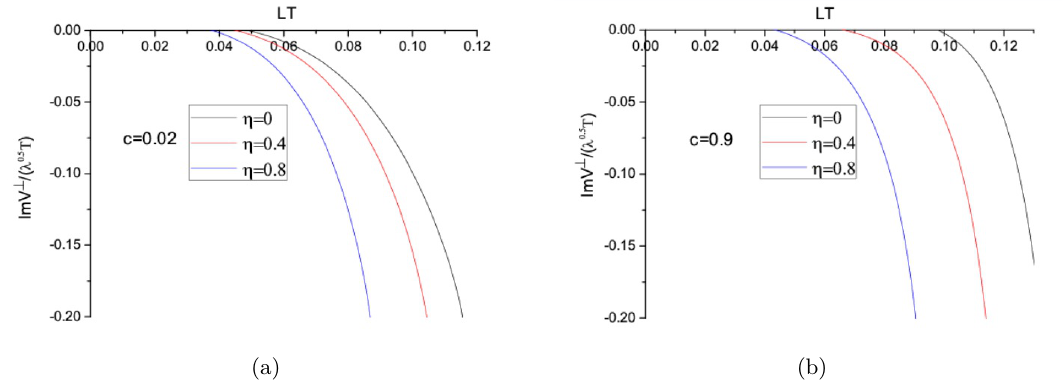
Figure 4 . Im V as a function of LT for a Q ¯ Q pair oriented transverse to the axis of the quarks, Q ¯ Q from left to right for η = 0 . 8 , 0 . 4 , 0 respectively, T = 200 MeV , in the presence of GC, for a) c = 0 . 02 Ge V 4 and b) c = 0 . 9 Ge V 4